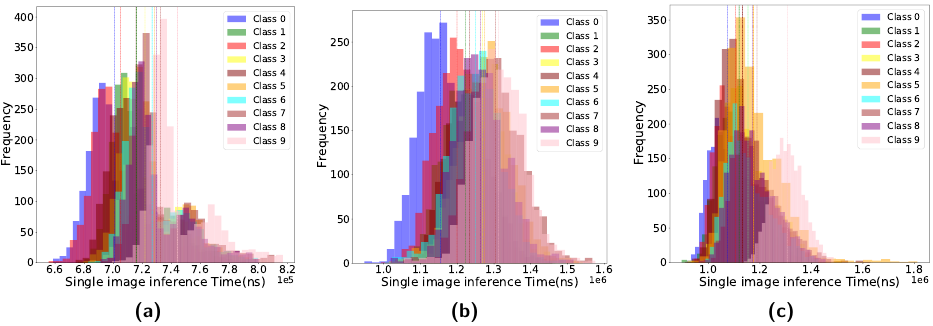
Figure 16: Frequency plots for 2000 CIFAR-10 image inference timings for 10 classes with (a) no parallel process, (b) 4 parallel processes and (c) 8 parallel